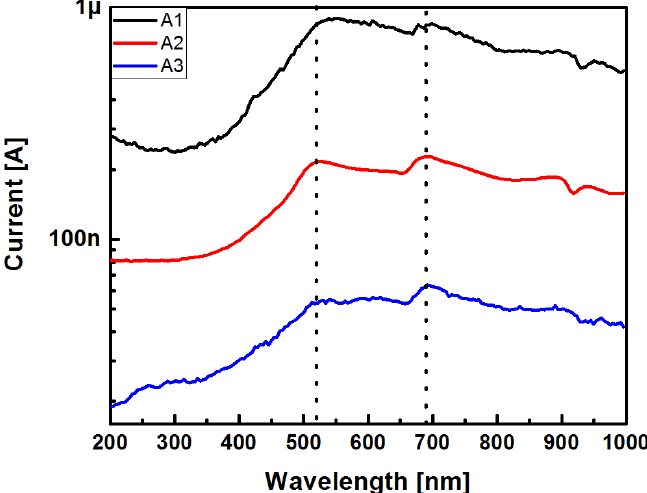
Figure 17. Curves I- λ of the Au/SRO/Si structures when reverse biased at − 4 V as a function of the incident light wavelength.